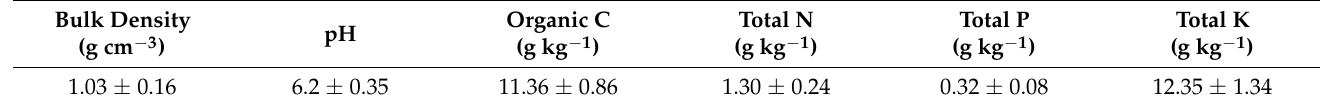
Table 1. Soil properties of the experimental